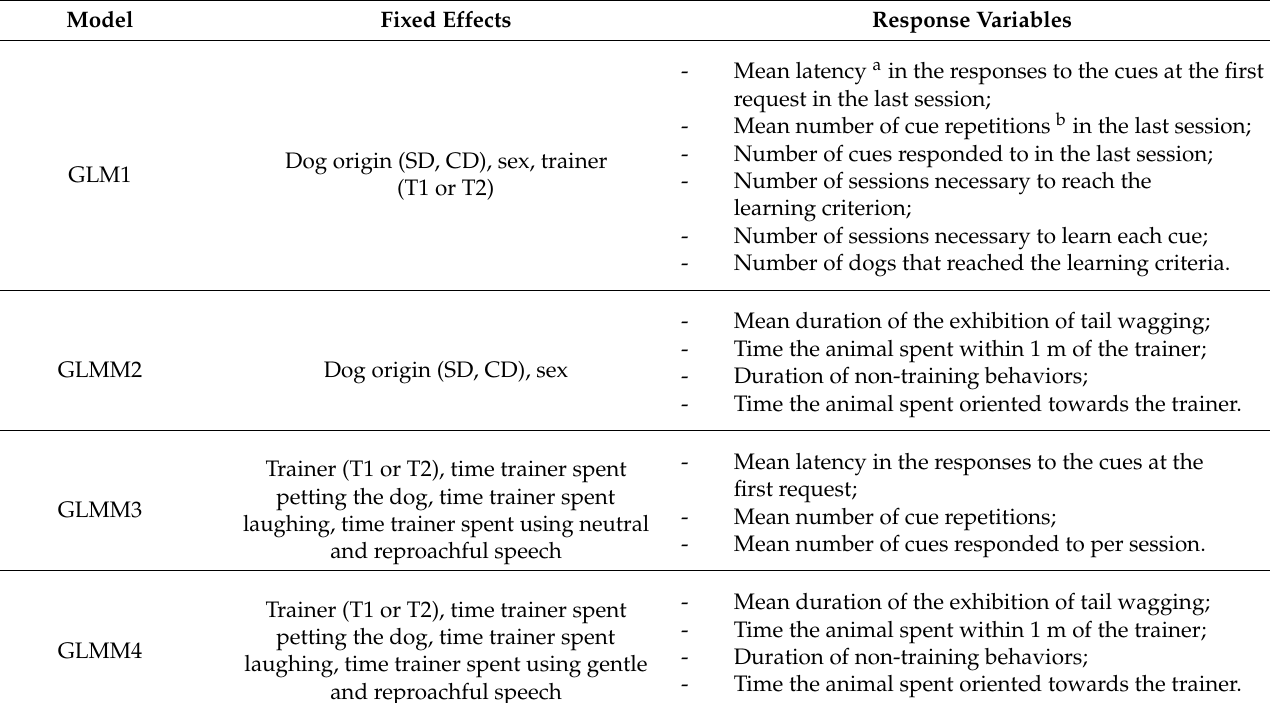
Table 3. Fixed effects and response variables used in GLM/GLMM models to evaluate the performance and general behavioral responses of dogs during training